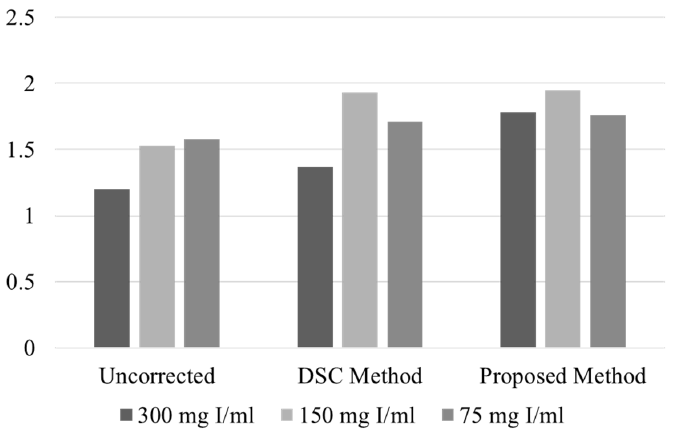
Figure 3. The projection intensity ratio of the yellow ROI to the red ROI shown in Figure